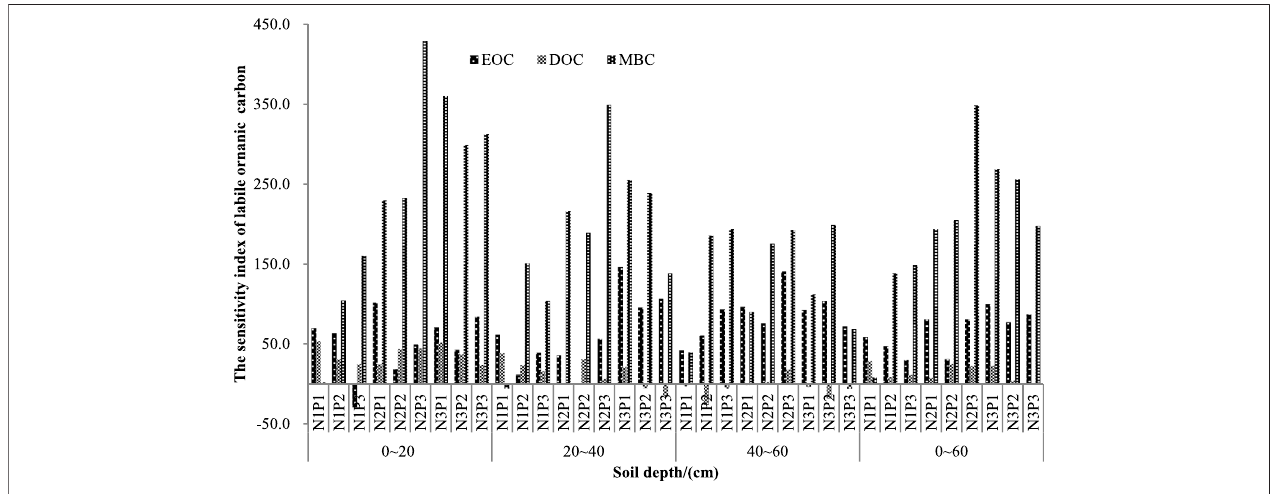
FIGURE 2| The sensitivity index of soil labile organic carbon under different fertigation treatments (N 1 – N 3 : 40, 60, and 80 mg L − 1 , respectively;P 1 – P 3 : 10, 20, and 30 mg L − 1 , respectively). EOC, easily oxidized organic carbon; DOC, dissolved organic carbon; MBC, microbial biomass carbon.